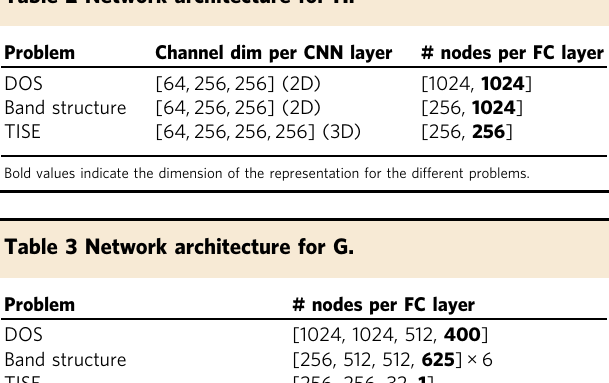
Table 2 Network architecture for H.